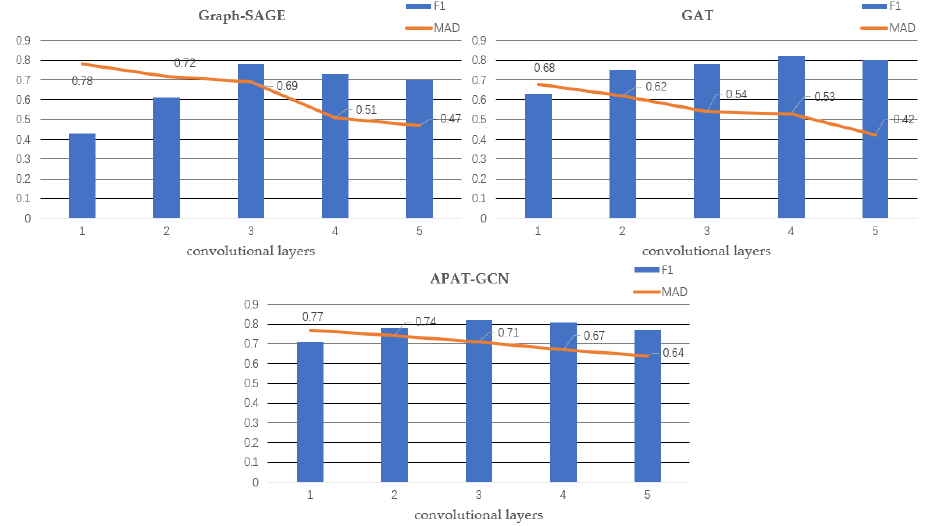
Figure 6. The relationship between the MAD and F1 indicators of the three models and number of layers.